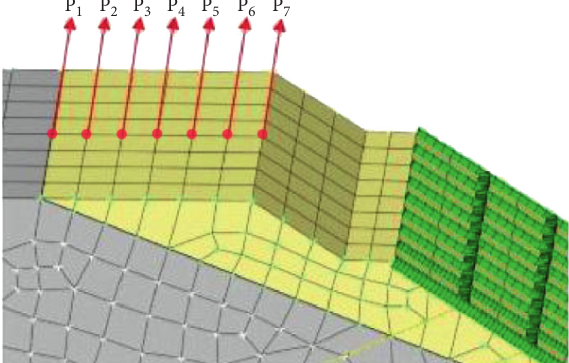
Figure 8: Characteristic point schematic